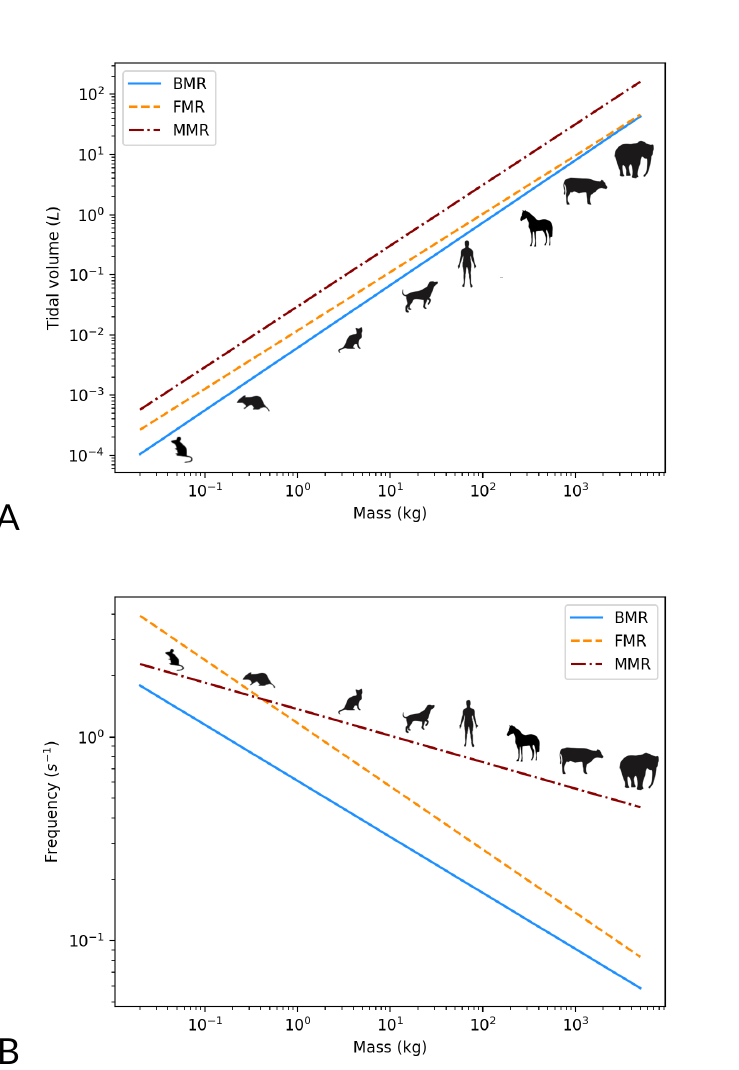
Figure 2 – A: Predicted tidal volume as a function of the mammal mass (log-log). Solid 6.1 M 1.04 ml; dashed line: FMR, V FMR line: BMR, V BMR T ’ 29.7 M 1.01 ml. B: Predicted breathing frequency as a function of line: MMR, V MMR T ’ the mammal mass (log-log). Solid line: BMR, f BMR b f FMR 1.17 M − 0.31 Hz, dash-dotted line: MMR, f MMR b ’